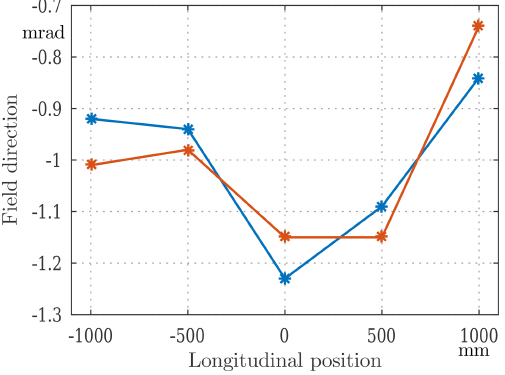
Figure 11. Axis measurement results of two scans with long coils. The plot is centered at the average axis measured by a stretched- wire system.